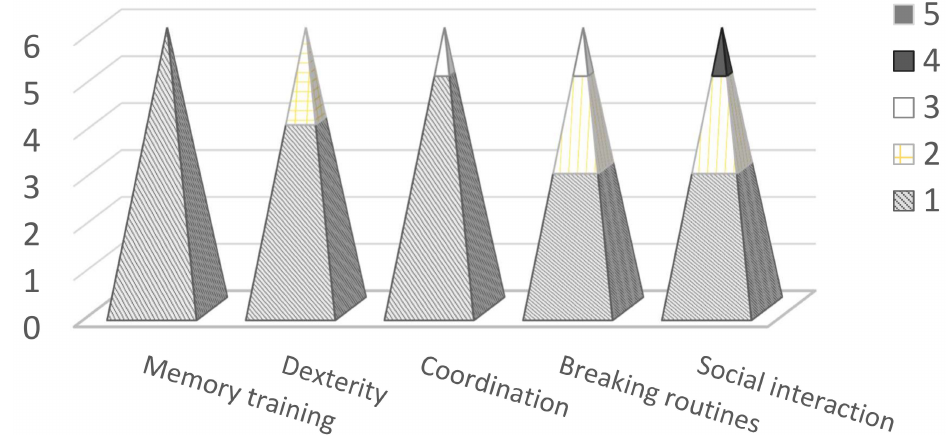
Figure 4. Results from the nursing staff interview in China (six staff members): The benefits of mobile gaming on different areas of the lives of the elderly on a scale of 1–5, where 1 is “very beneficial” and 5 is